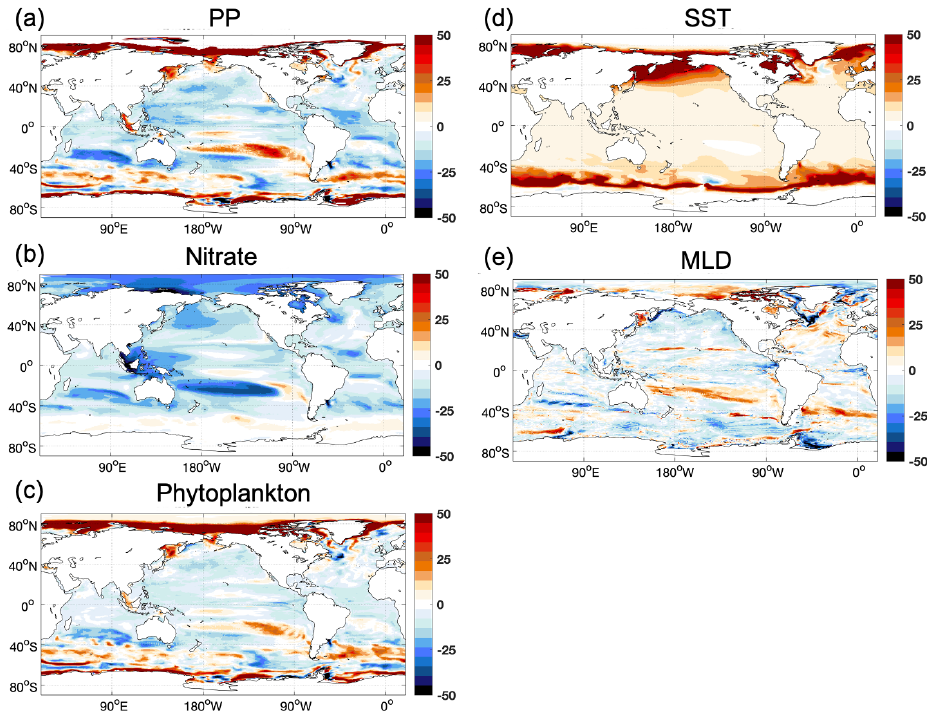
Figure A2. The relative changes in projected (a) primary production, (b) nitrate concentration, (c) phytoplankton concentration, (d) sea surface temperature, and (e) annual mean maximum mixed layer depth in REF (2050–2099 compared to